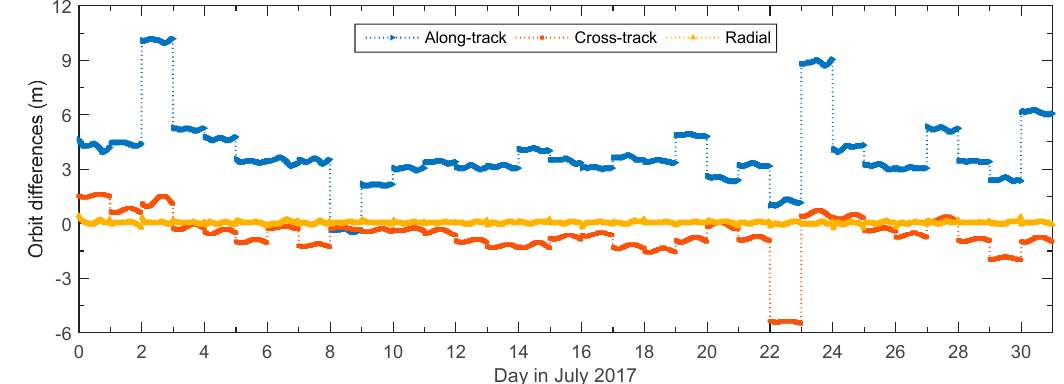
Figure 1. Orbit difference series in along-track, cross-track, and radial components with 15 min sampling interval for BeiDou C02 between the GBM and WUM orbit products during July 2017. Blue dots represent along-track, red dots represent cross-track, and yellow dots represent radial.